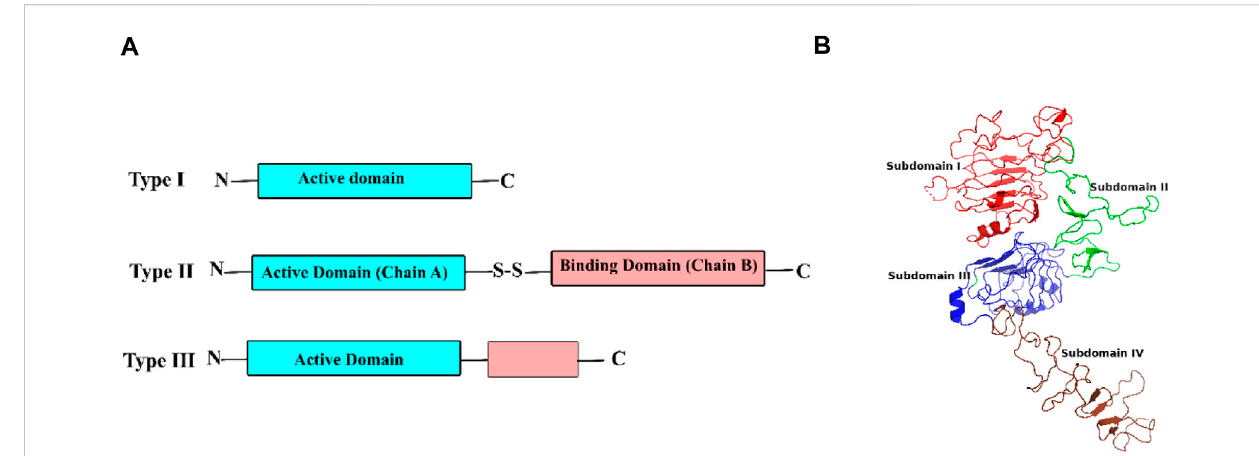
FIGURE 1 (A) The structure of three types of RIPs (ribosome inactivating proteins) and (B) extracellular domains of ErbB2 (PDB ID